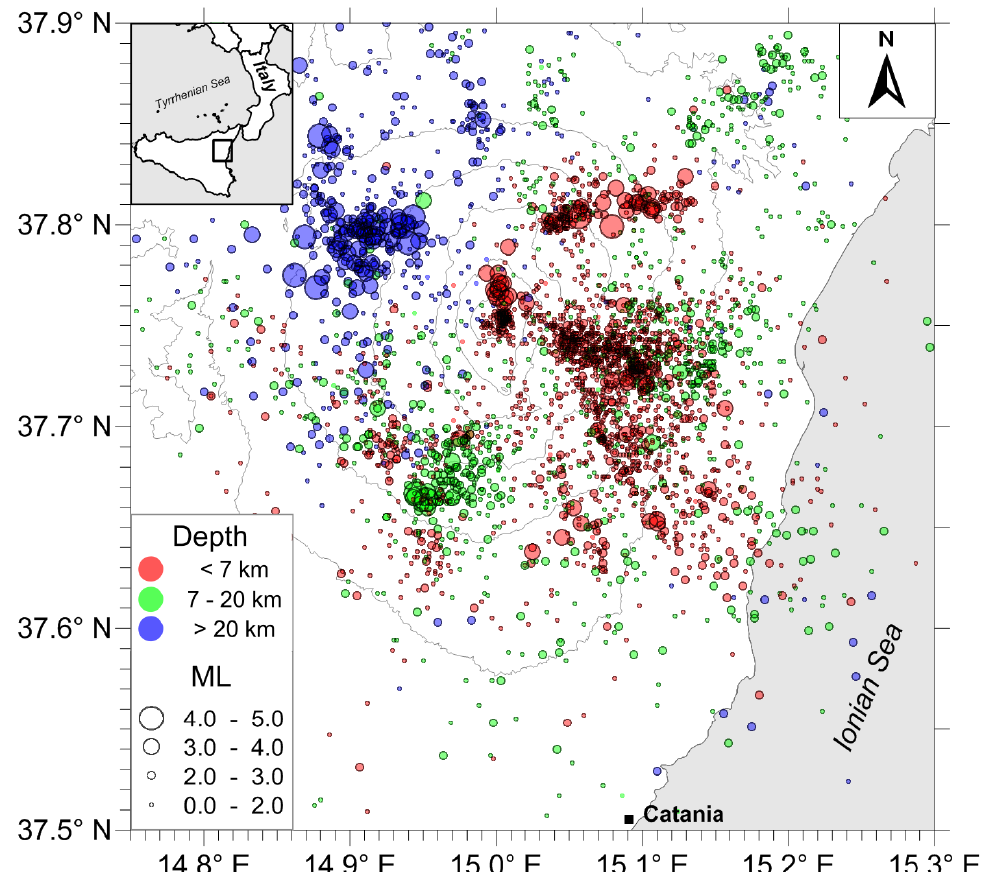
Figure 1. Map of Mt. Etna volcano and spatial distribution of the earthquakes used in this